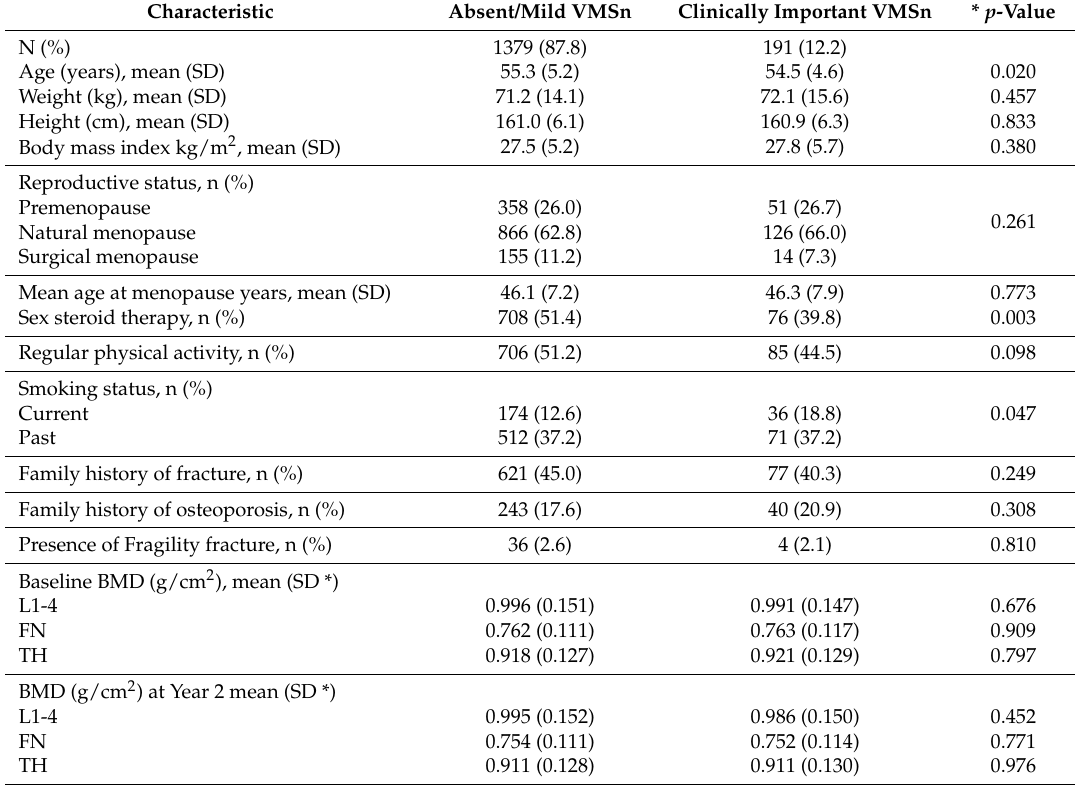
Table 1. Population Characteristics at Baseline of Women ages 43-63 in the Canadian Multicentre Osteoporosis